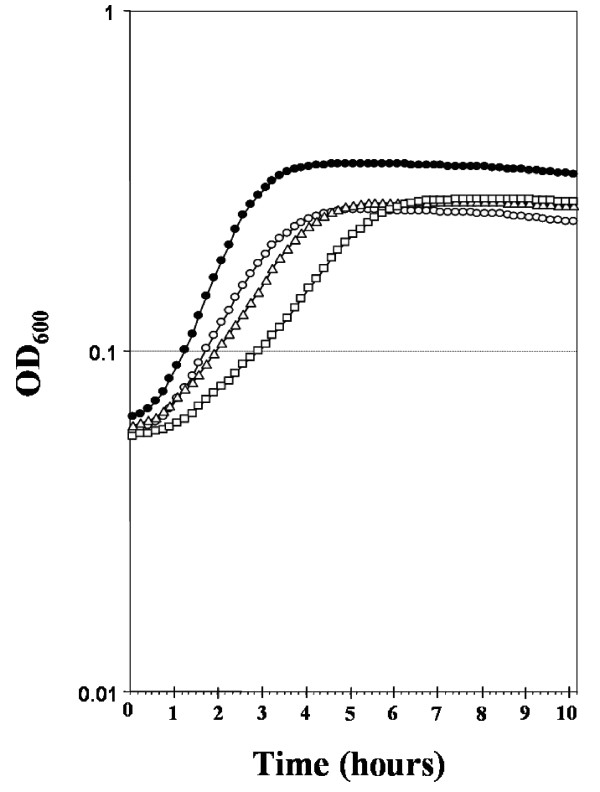
Growth rates of different strains. Overnight cultures of E. coli strains grown in LB medium were diluted (1/200) and subcultured in fresh LB medium supplemented with 0.5% D-(+)-glucose and chloramphenicol. MG1655 (pCA24N) (filled circles), JMG1655 ΔrecA (pCA24N) (open circles), JMG1655 ΔrecA (pRecA-Htg) (open triangles), and JMG1655 ΔrecA (pRecA-GFP) (open squares)